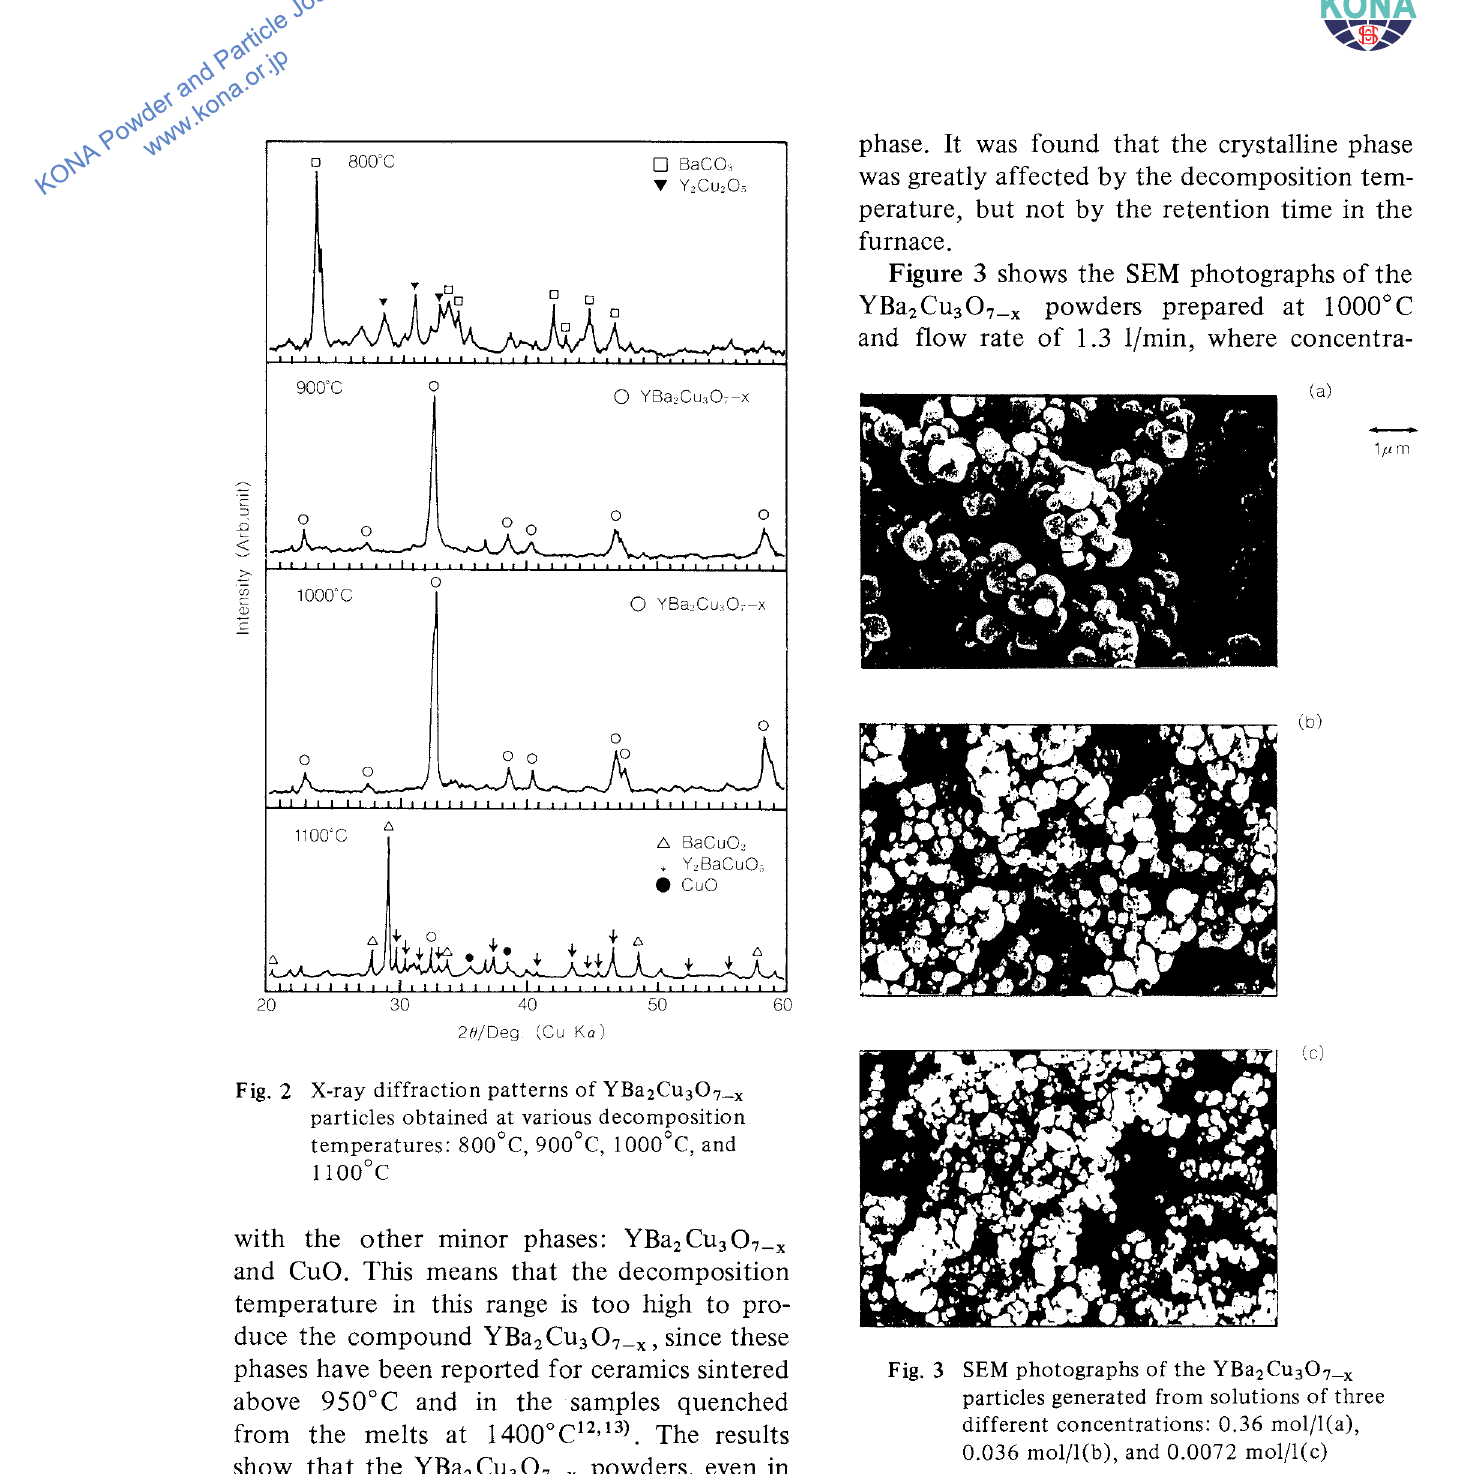
Fig. 3 SEM photographs of the YBa 2 Cu 3 0 7 _x particles generated from solutions of three different concentrations: 0.36 mol/l(a), 0.036 mol/l(b), and 0.0072